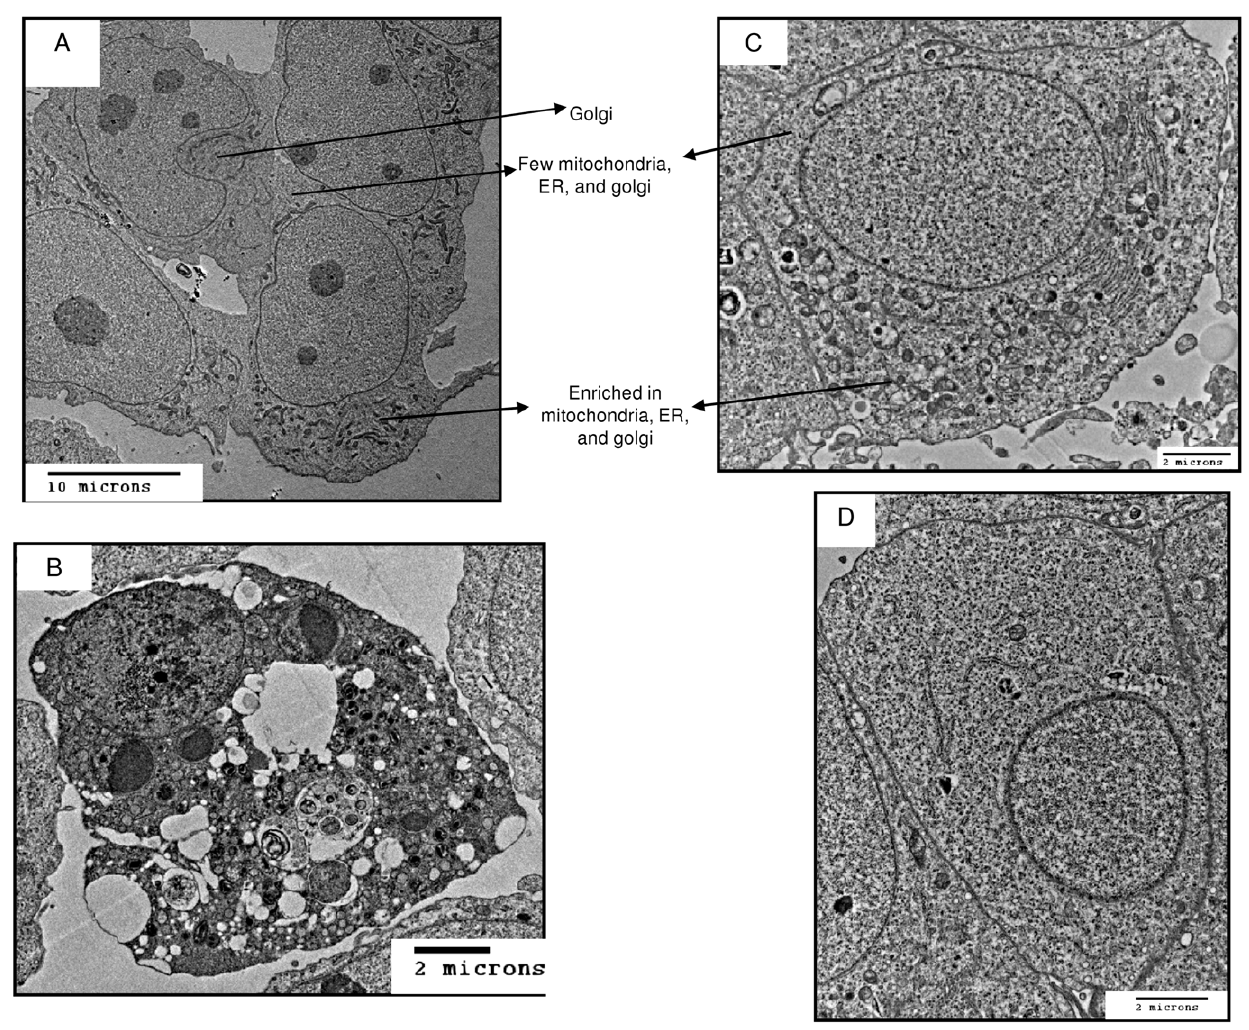
Figure 2. CHA59 spheres contained a heterogeneous cell population as compared with monolayers, visualized by transmission electron microscopy. (A) Monolayers contained polarized cells – one end rich in organelles, 500 6 magnification. (B, C, D) Spheres contained (B) dead (1,000 6 magnification), (C) polarized (2,000 6 magnification), and (D) organelle-deficient cells (2,000 6 magnification).